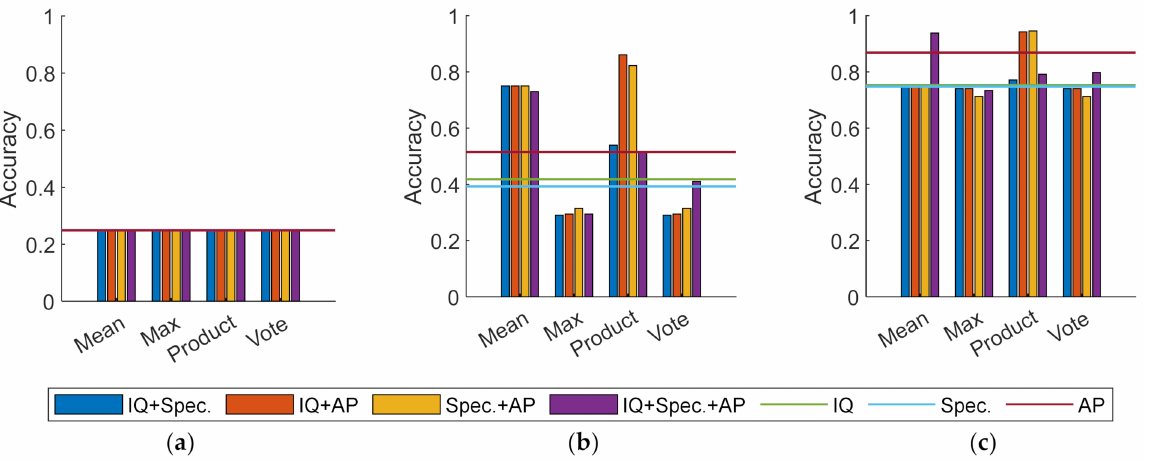
Figure 16. Accuracy of experiments with different combinations. ( a ) Softmax as basic classifiers; ( b ) softmax-threshold as basic classifiers; ( c ) OpenMax as basic